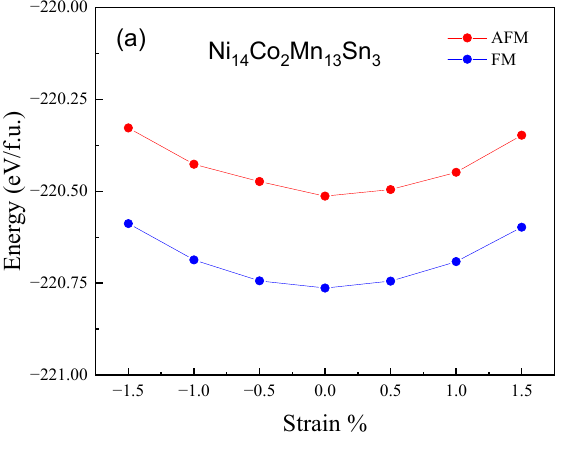
T C ( K ) Figure 6. Strain change ( − 1.5~1.5%) of the T M and the T C in Ni 14 Co 2 Mn 13 Sn 3 .